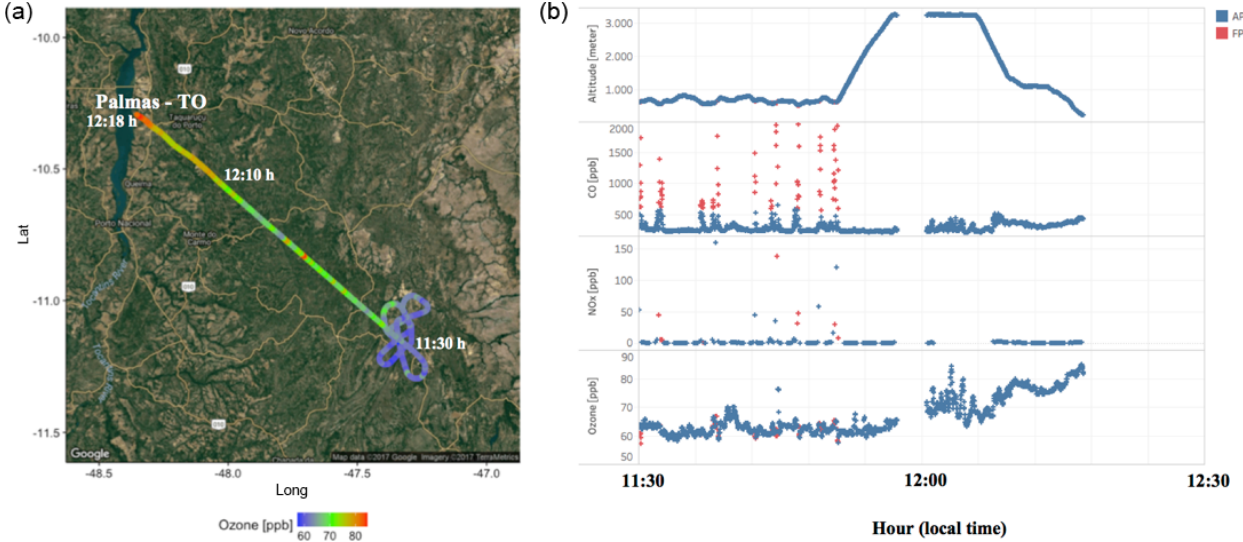
Figure 4. (a) the track of flight B742 that landed in Palmas – TO. The color bar represents the measured O 3 mixing ratios (ppbv) along the flight track. (b) From top to bottom, the altitude and the CO, NO x , and O 3 mixing ratios (ppbv) measured along the B742 flight track. The red and blue dots represent the parts of the flight track classified as fresh (FP) and aged (AP) smoke plumes, respectively. Table 4. Airborne measurements of isoprene, oxidation ratio [MVK + MACR + ISOPOOH] / [isoprene], and OH in remote areas and biomass burning environments worldwide. Standard error reported in parentheses for this